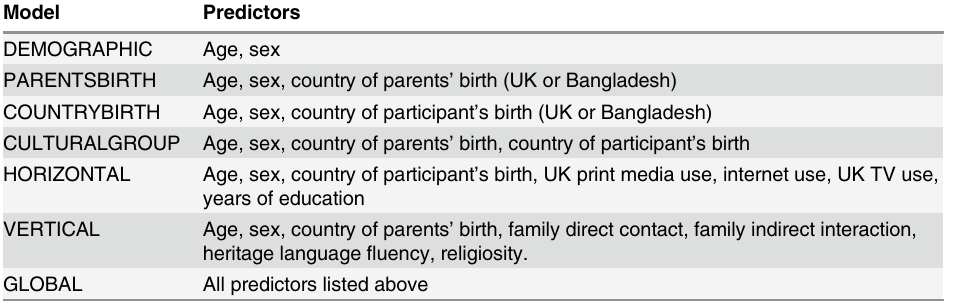
Table 3. Summary of predicted models used in model